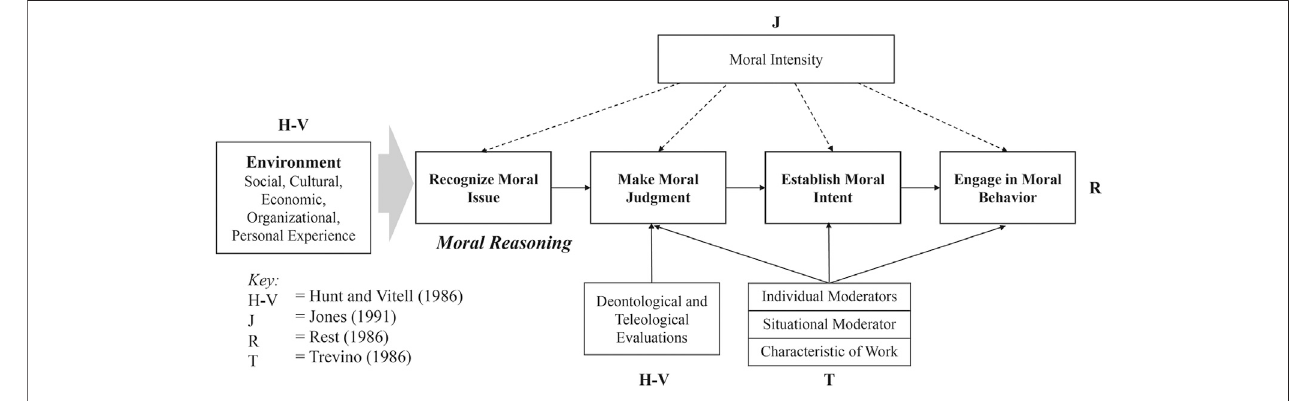
FIGURE 1 | Rationalist approach of ethical decision-making.